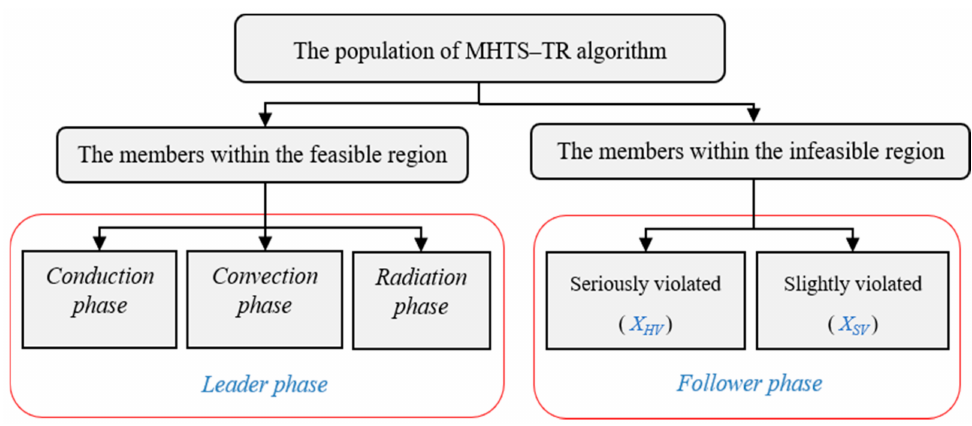
Figure 2. The overall scheme of the MHTS–TR